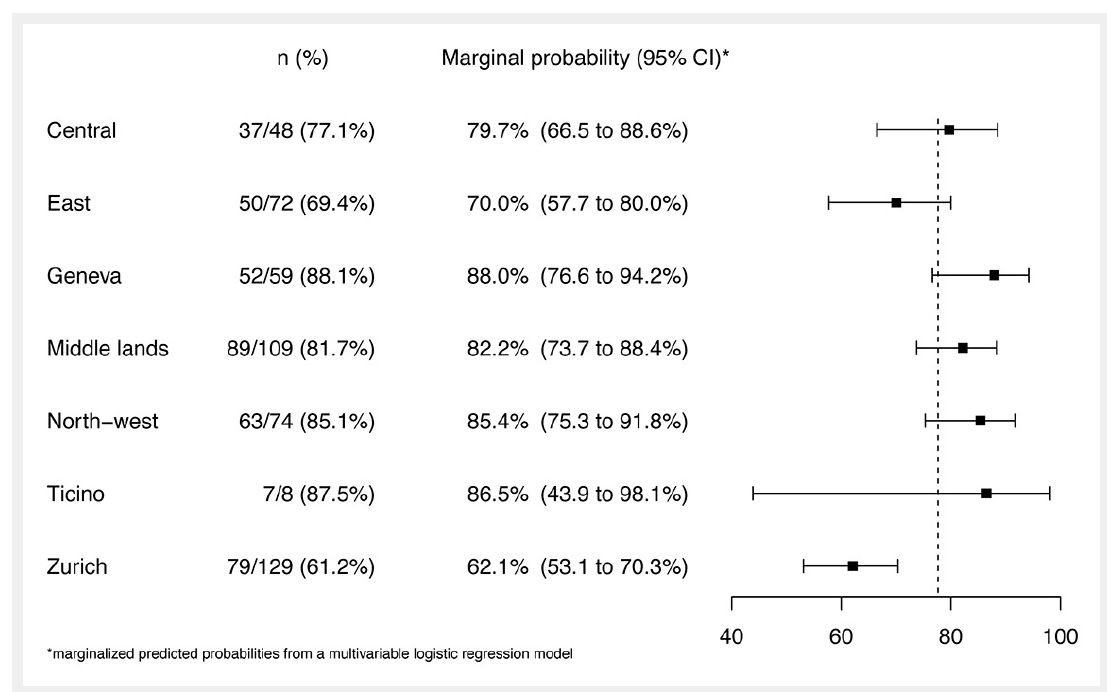
Figure 3 Probability of reporting testing of all women for human immunodeficiency virus (HIV), hepatitis B virus (HBV) and syphilis, by region adjusted for place of work, year of specialist certification, and gender. The dashed line indicates the overall mean, boxes are the point estimate, bars are 95% confidence intervals